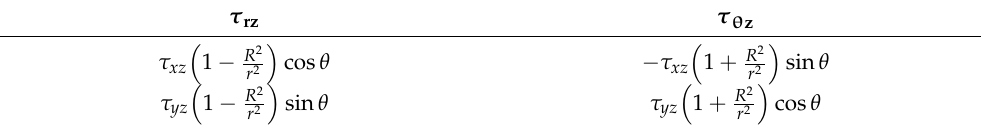
Table 3. Stress distribution expression for the surrounding strata caused by τ xy , and τ yz